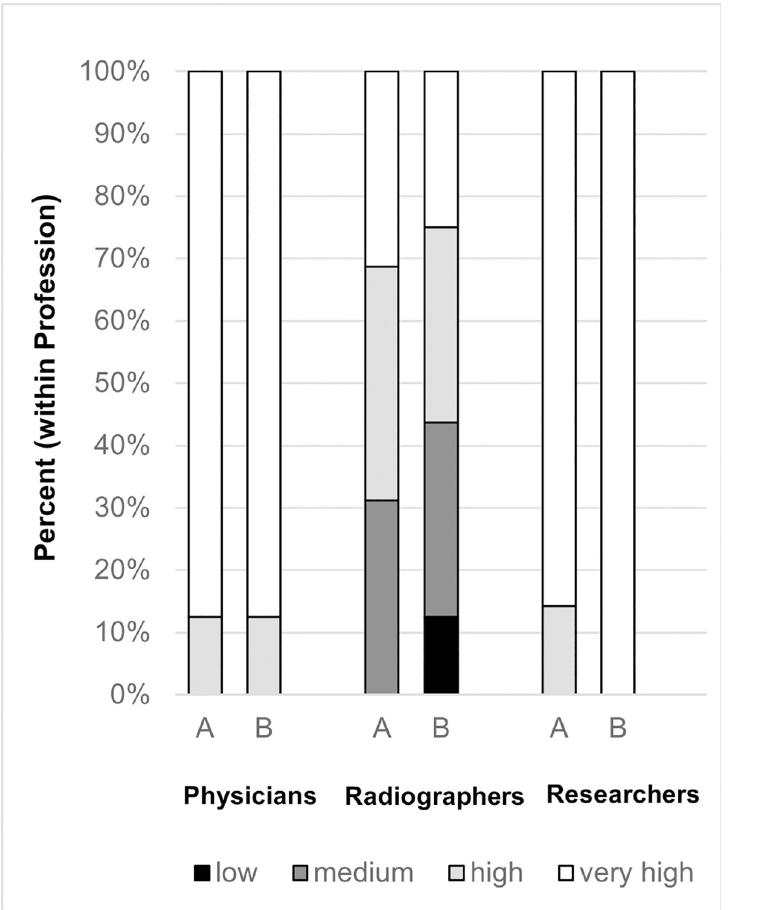
Fig 1. Valuation of usefulness of EST before (A) and after (B) the